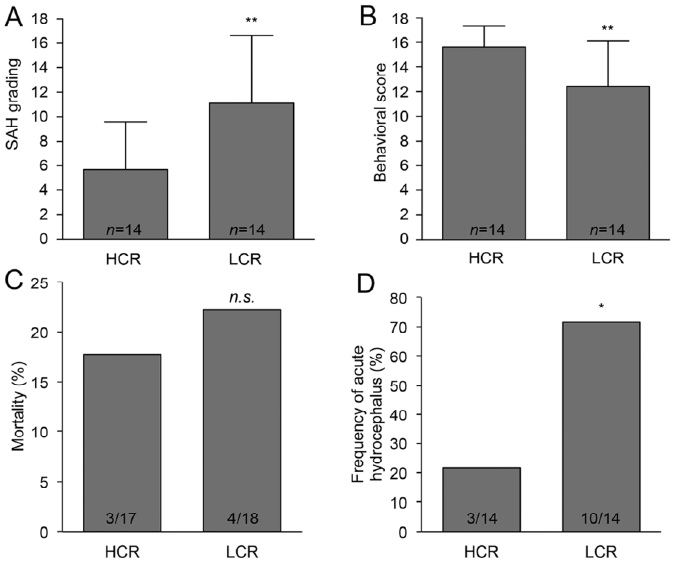
Figure 1. LCR rats had worse SAH grades and behavioral scores, as well as a higher occurrence of hydrocephalus. SAH grades ( A ) and behavioral scores ( B ) in HCR and LCR rats. ** p < 0.01 versus HCR group. The % of HCR and LCR rats that died after SAH ( C ) and had acute hydrocephalus 24 h after SAH ( D ); * p < 0.05, n.s. (not significant) p > 0.05 versus HCR group. Hydrocephalus was determined when the ventricular volume increased more than +3 SD above the mean in sham rats. The frequency of hydrocephalus was significantly greater in LCR (71%; 10/14) than in HCR rats (21%; 3/14; p < 0.05, Figure 1D). In LCR rats, SAH induced apparent ventricular enlargement at 24 h (26.0 ± 12.3 mm 3 ; n = 14) com- pared with HCR rats (12.8 ± 4.9 mm 3 ; n = 14; p < 0.01, Figure 2A,B). In addition, the per- centage of damaged ventricular wall was higher in LCR rats (8.3 ± 2.7%; n = 7) than in HCR rats (1.03 ± 0.6%; n = 7; p < 0.01, Figure 2C,D).